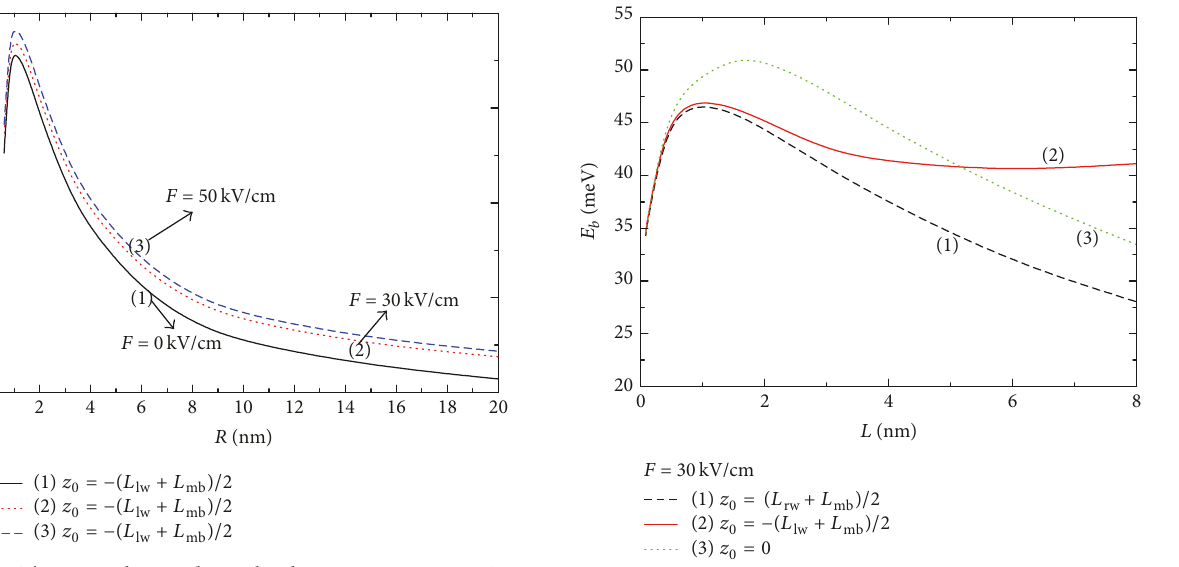
Figure 3: The ground-state donor binding energy 𝐸 𝑏 in a ZB In 𝑥 Ga 1−𝑥 N/GaN symmetric coupled QDs as a function of the QD thickness 𝐿 (𝐿 lw = 𝐿 rw = 𝐿) for 𝑅 = 10 nm, 𝐿 mb = 1 nm, 𝐹 = 30 kV/cm, 𝜌 = 0 . Curves 1, 2, and 3 are for the impurity 0 positions 𝑧 0 = (𝐿 rw + 𝐿 mb )/2 , −(𝐿 lw + 𝐿 mb )/2 , 0,